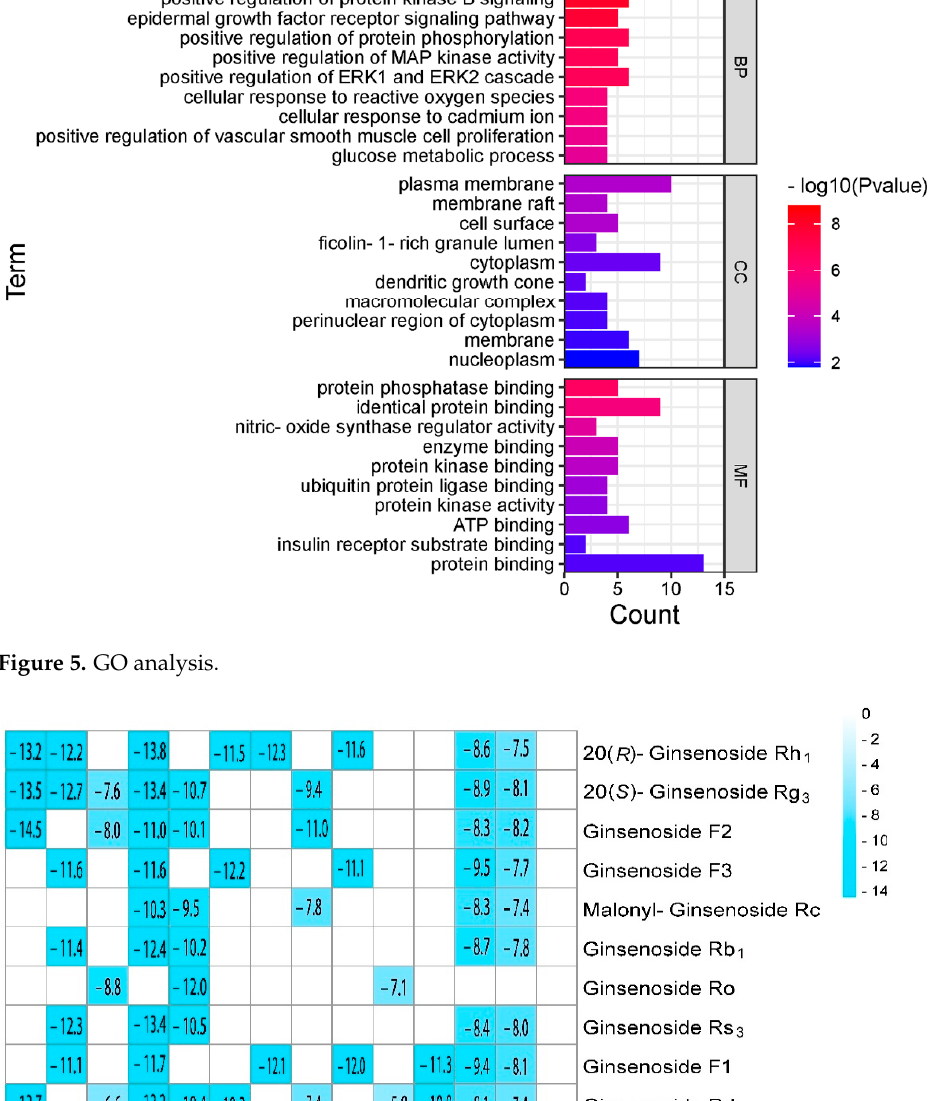
Figure 4. KEGG pathway enrichment.